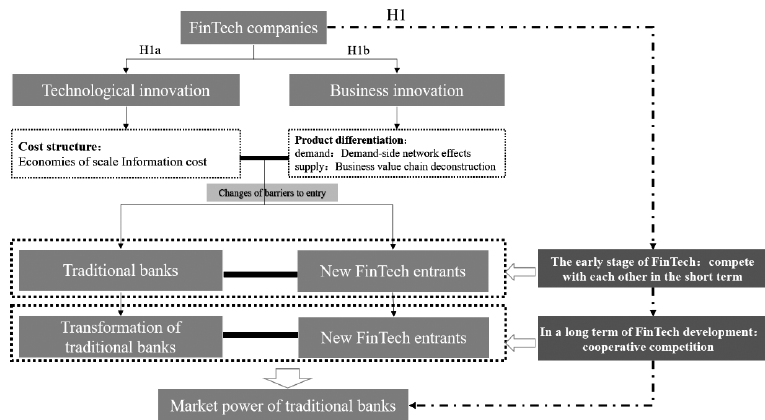
Figure 3. The mechanism of FinTech’s influence on the market power of traditional